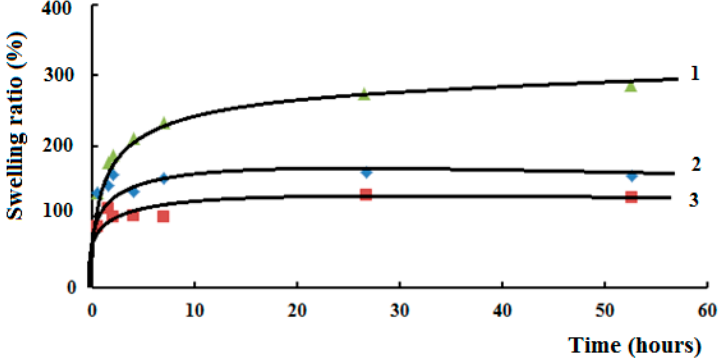
Figure 9. Swelling kinetics of chitosan hydrochloride/citrus pectin hydrogels in 0.9% solution of AlCl 3 (1), CaCl 2 (2), NaCl (3). Data are expressed as mean ± SD; n = 3.